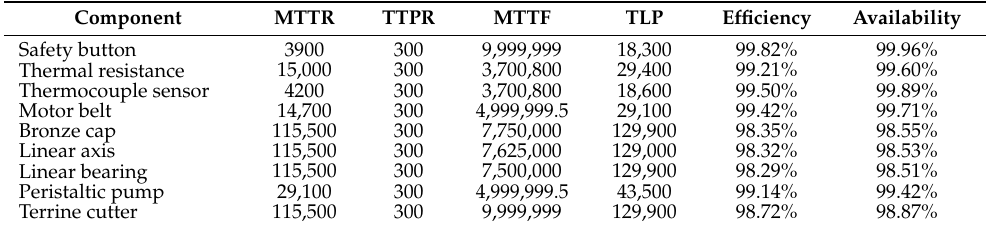
Table 12. Mechanical component times in seconds. Efficiency and availability calculated in % with the IPPM strategy.